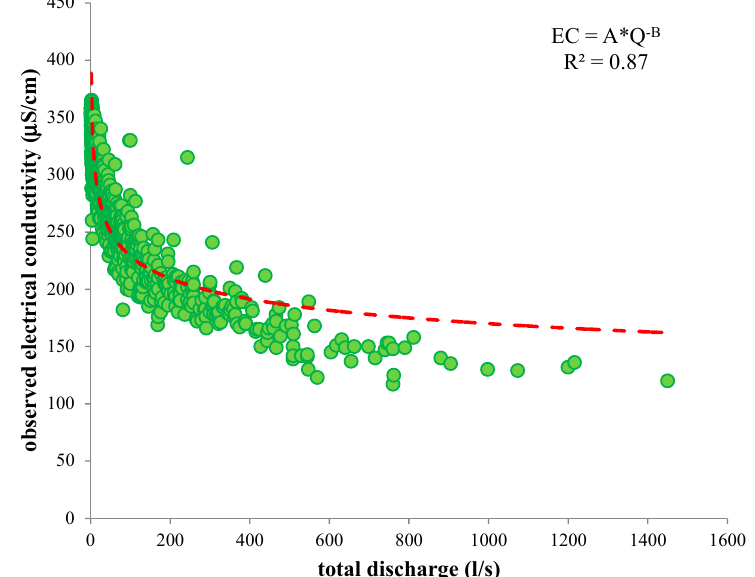
Figure 2. Relationship between total discharge and electrical conductivity monitored at the daily scale for the Ciciriello catchment.